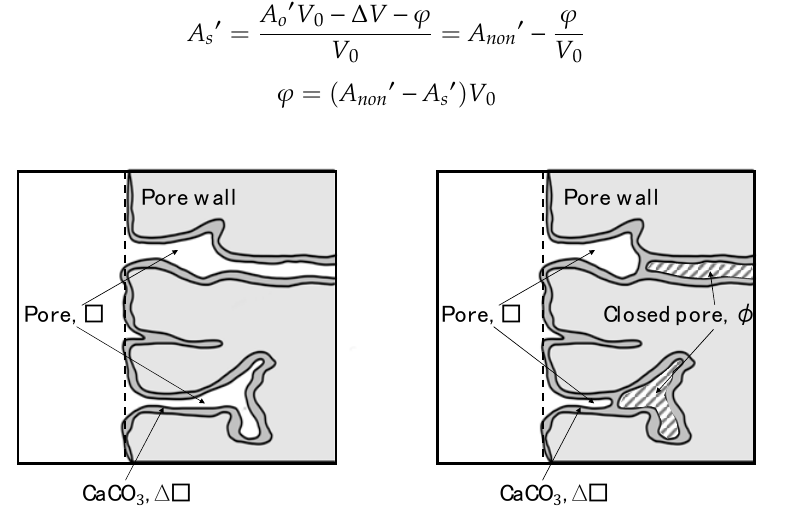
Figure 8. Schematic diagram of the state of pores without ( left ) and with ( right ) clogging effect.